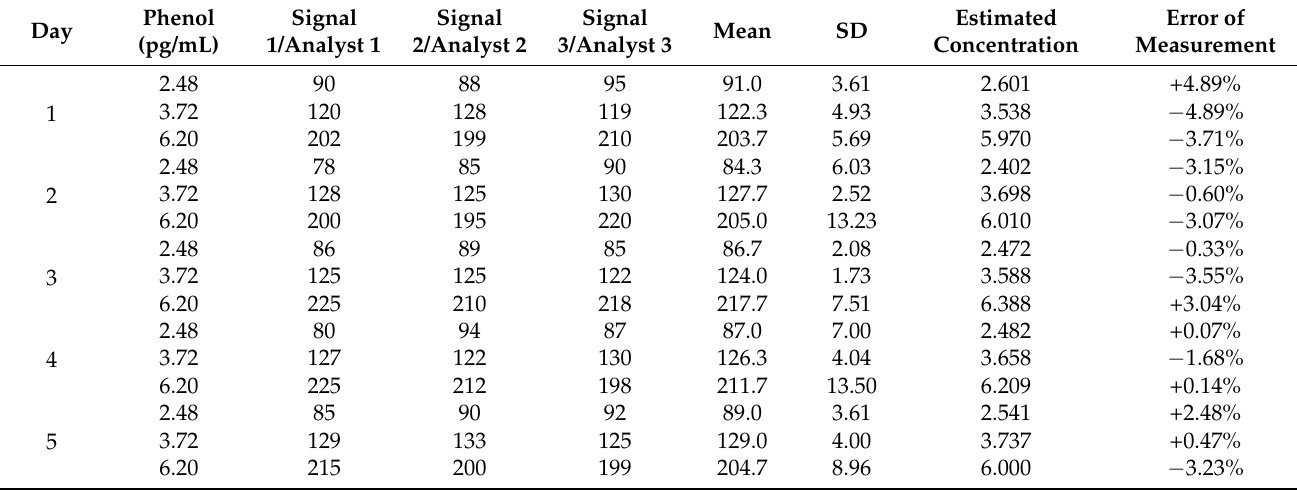
Table 1. Intermediate precision results for phenol detection with the metal-supported lipid membrane biosensor incor- porating 2.5 µ g/mL tyrosinase (0.1M KCl buffered with HEPES; 0.5 mm diameter Teflon-coated silver wire; pH 8.0; 25 ◦